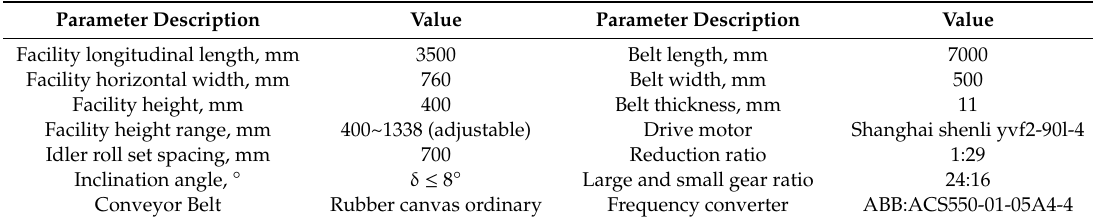
Table 1. Parameters of the experimental facility.